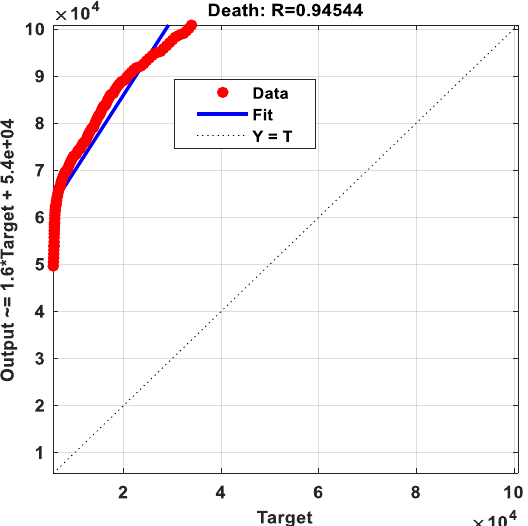
( b ) The correlations coefficients and the linear regression equations between the observed recovered values and the target values (PPA-MMLPNN model values) for Mexico.